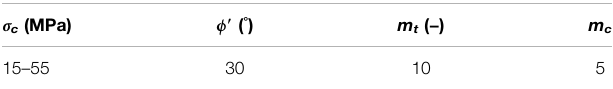
TABLE 4 | Strength properties of the shaly